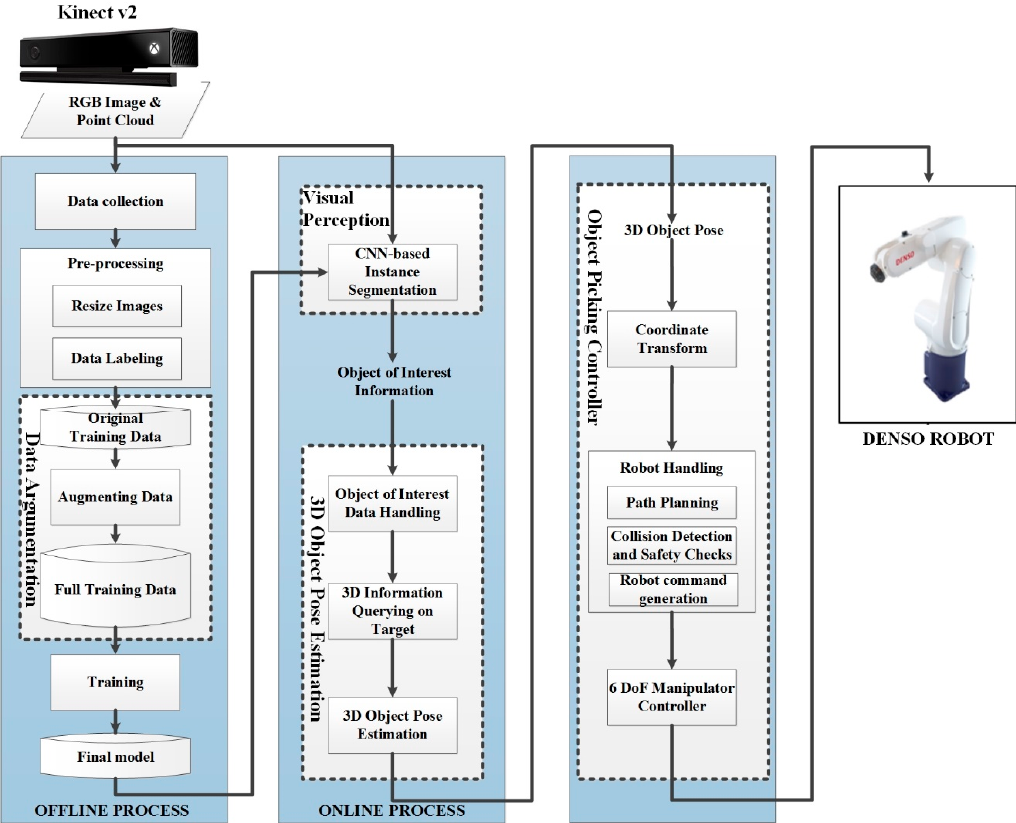
Figure 1. Architecture of the proposed system.